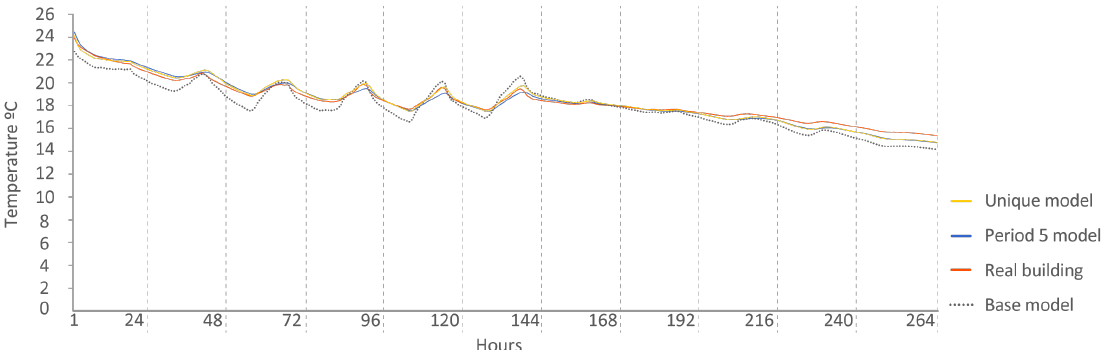
Figure 21. Temperature in house N2, Period 5 (free oscillation). Period 5 model: CV(RMSE): 1.67%, NMBE: 0.37%, and R 2 : 99.01%. Base model: CV(RMSE): 3.84%, NMBE: 2.52%, and R 2 : 92.43%. Unique model: CV(RMSE): 1.63%, NMBE: 0.11%, and R 2 : 98.66%.